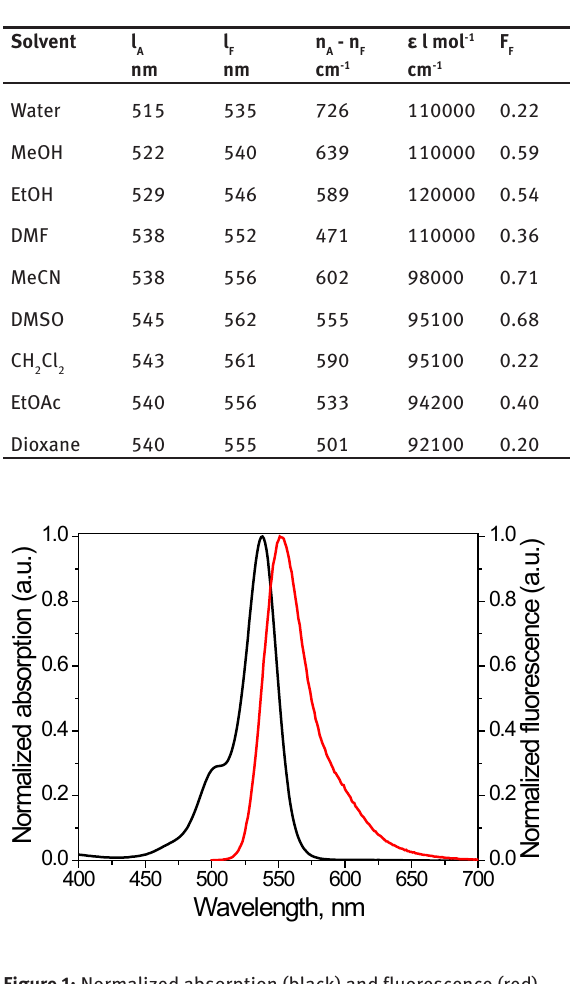
Figure 1: Normalized absorption (black) and fluorescence (red) spectra of the compound E in N,N -dimethylformamide